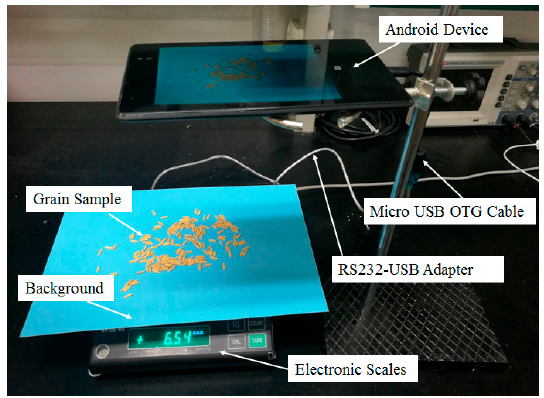
Figure 1. The experimental setup for the system.